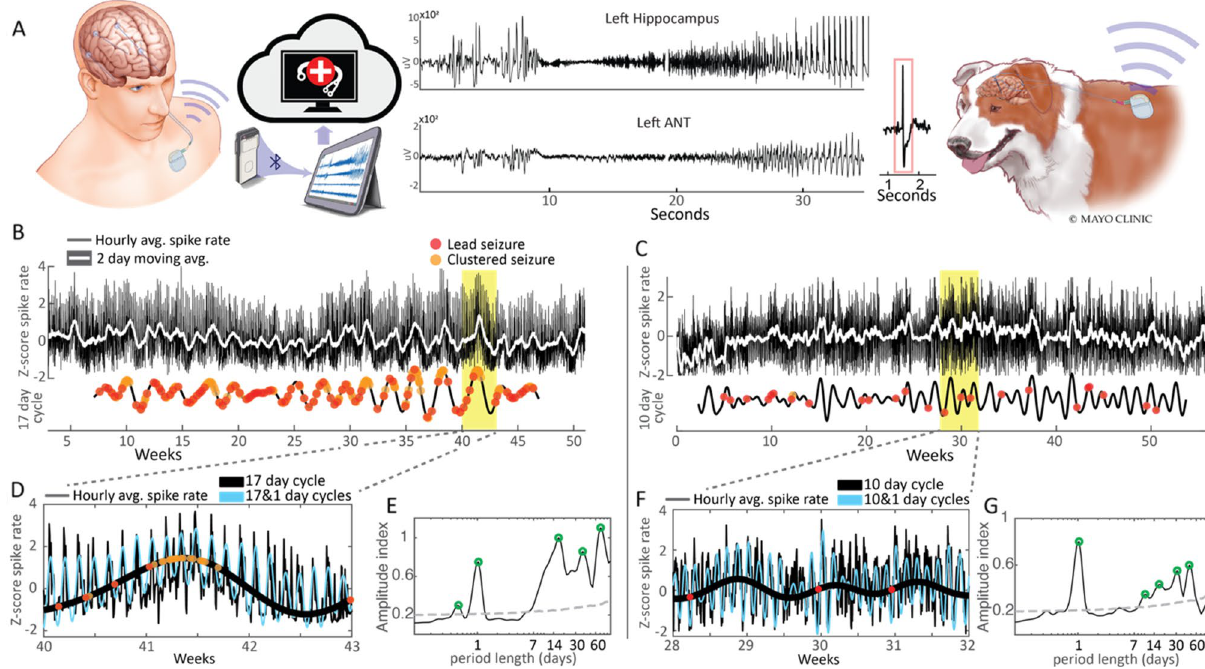
Figure 1. Brain recordings, IES rate and seizures. Long-term intracranial EEG of human (H1, left panel) and canine (D1, right panel) epilepsy. ( A ) Schematic of implanted chronic brain recording devices. ( B , C ) Hourly average IES rate, two-day moving average, and multiday IES rate cycles. ( D , F ) Magnified view of circadian and multiday IES rate cycles and seizures. ( E , G ) Amplitude spectral density of IES rate. The grey dashed line marks the 95th percentile of normally distributed white noise. Significant local maxima in the ASD plot are marked by green circles. ASD amplitude spectral density, D1 dog 1, H1 human 1, IES Interictal epileptiform